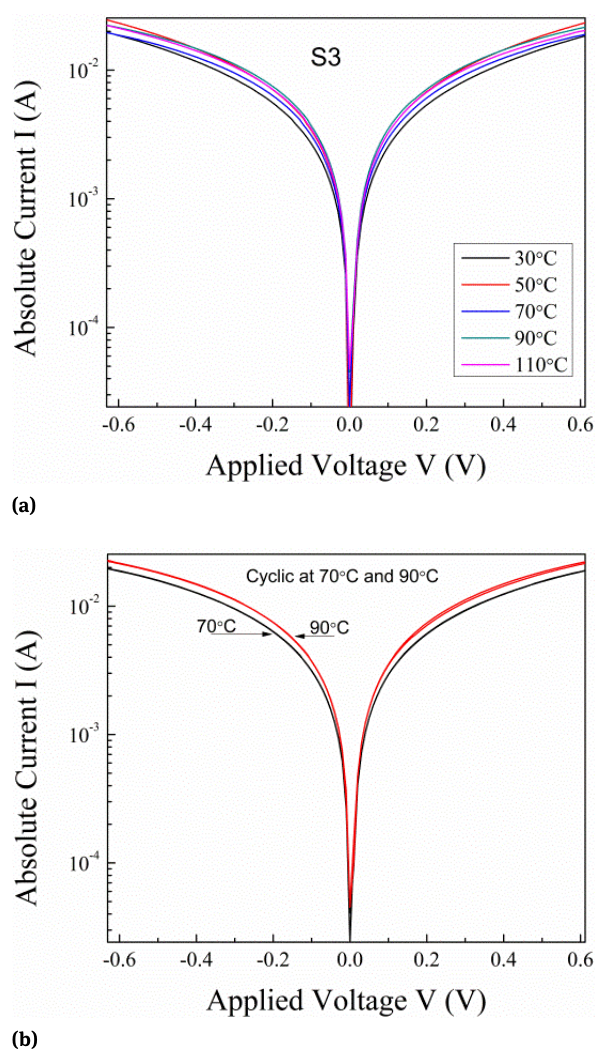
Figure 5: I-V characteristics for PANi/PVA/15 wt% Fe 3 O 4 blend nanocomposites a) at different temperatures b) cyclic runs at 70 and 90 ∘ C.